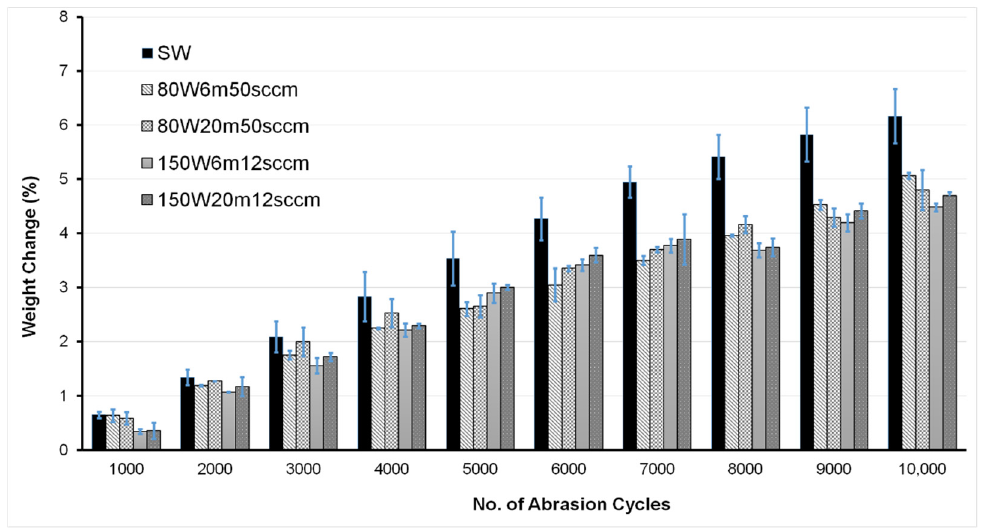
Figure 4. Weight loss of untreated and plasma-treated scoured wool fabrics at different numbers of abrasion cycles.